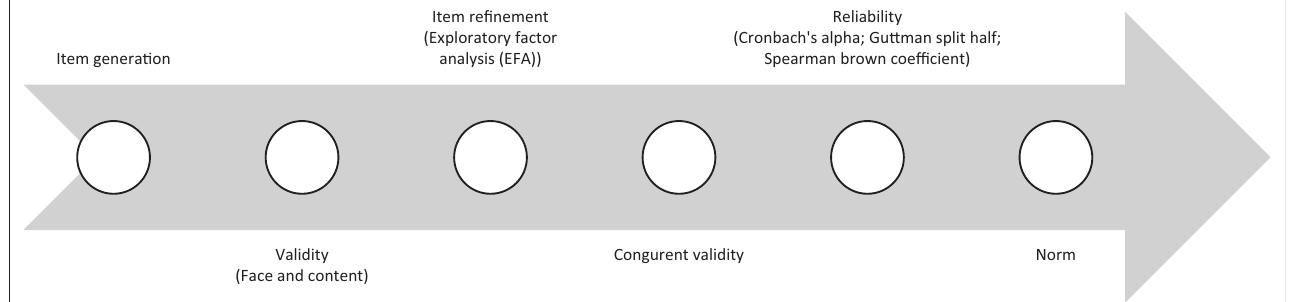
FIGURE 1 : Flow diagram for the suicidality scale development and validation.